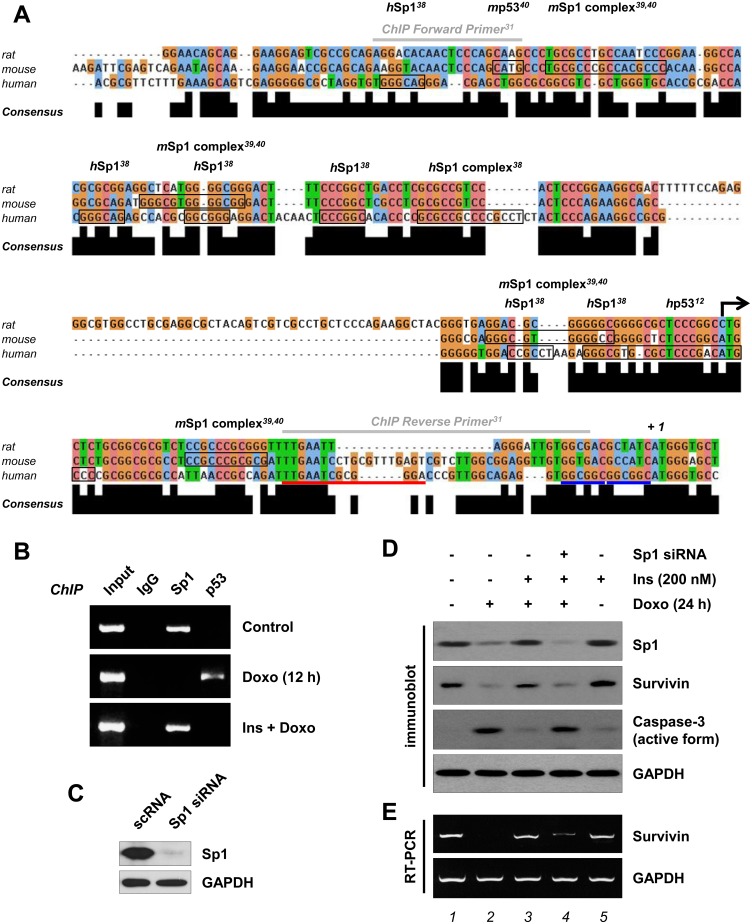
Effect of doxorubicin and/or insulin on the transcriptional activity of Sp1 and p53.(A) Multiple sequence alignment (ClustalW2) of the proximal promoter regions of the rat, mouse and human survivin genes. Black arrow indicates the transcriptional start site and +1 points out the translation start codon. Canonical p53, Sp1, Sp1-like sites of the mouse and human survivin genes are boxed [12, 38–40]. Two gray bars indicate the primers for ChIP analysis [31]; a red bar corresponds to human CHR sequences; two blue bars highlight human CDE regions [50]. (B) Serum-deprived cells were left untreated or pretreated with 200 nM insulin (Ins) for 1 h and treated with 1 μM doxorubicin (Doxo) for 12 h. Cross-linked cell lysates were subjected to ChIP analysis with anti-Sp1 or anti p53-antibody. RT-PCR (36 cycles) was performed with ChIP primers as listed in Materials and Methods (n = 5). (C–E) One day after transfection with Sp1 siRNA (20 nM), cells were left untreated or pretreated with insulin (200 nM) for 1 h and treated with doxorubicin (1 μM) for 24 h. Whole cell lysates were immunoblotted with anti-Sp1, anti-survivin and anti-caspase-3 (active form) antibodies (C, D), and total RNA was analyzed by RT-PCR (28 cycles) with specific primers to survivin gene (E). Note that these results represent one of three independent experiments.